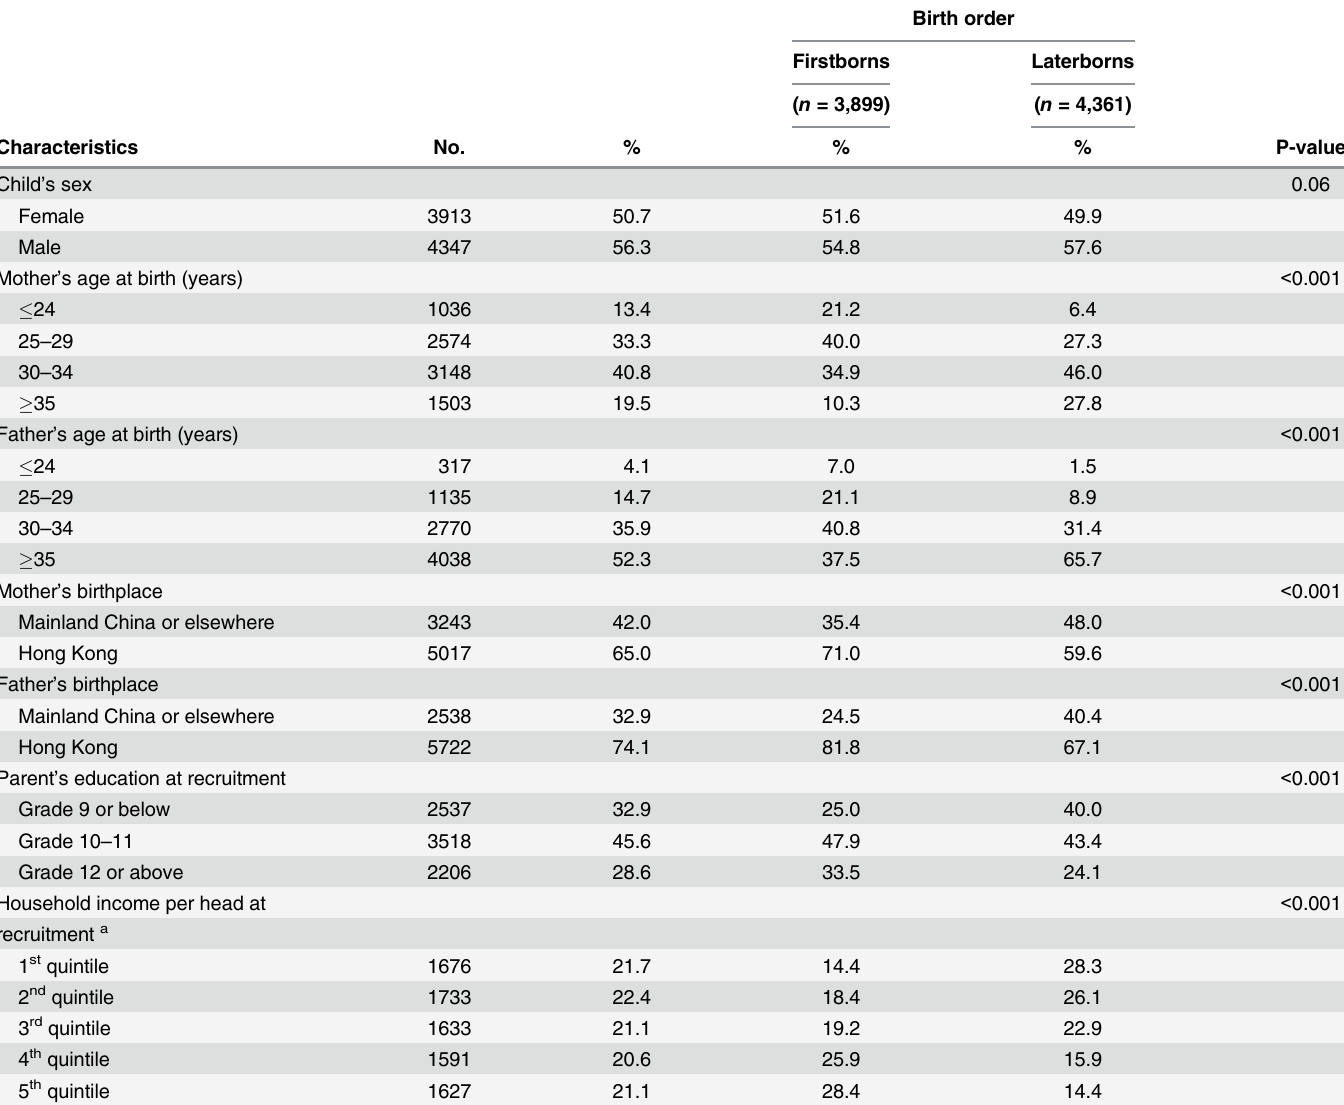
Table 1. Baseline characteristics by birth order for 8,260 adolescents from Hong Kong ’ s “ Children of 1997 ” birth cohort, Hong Kong, China, 1997 –